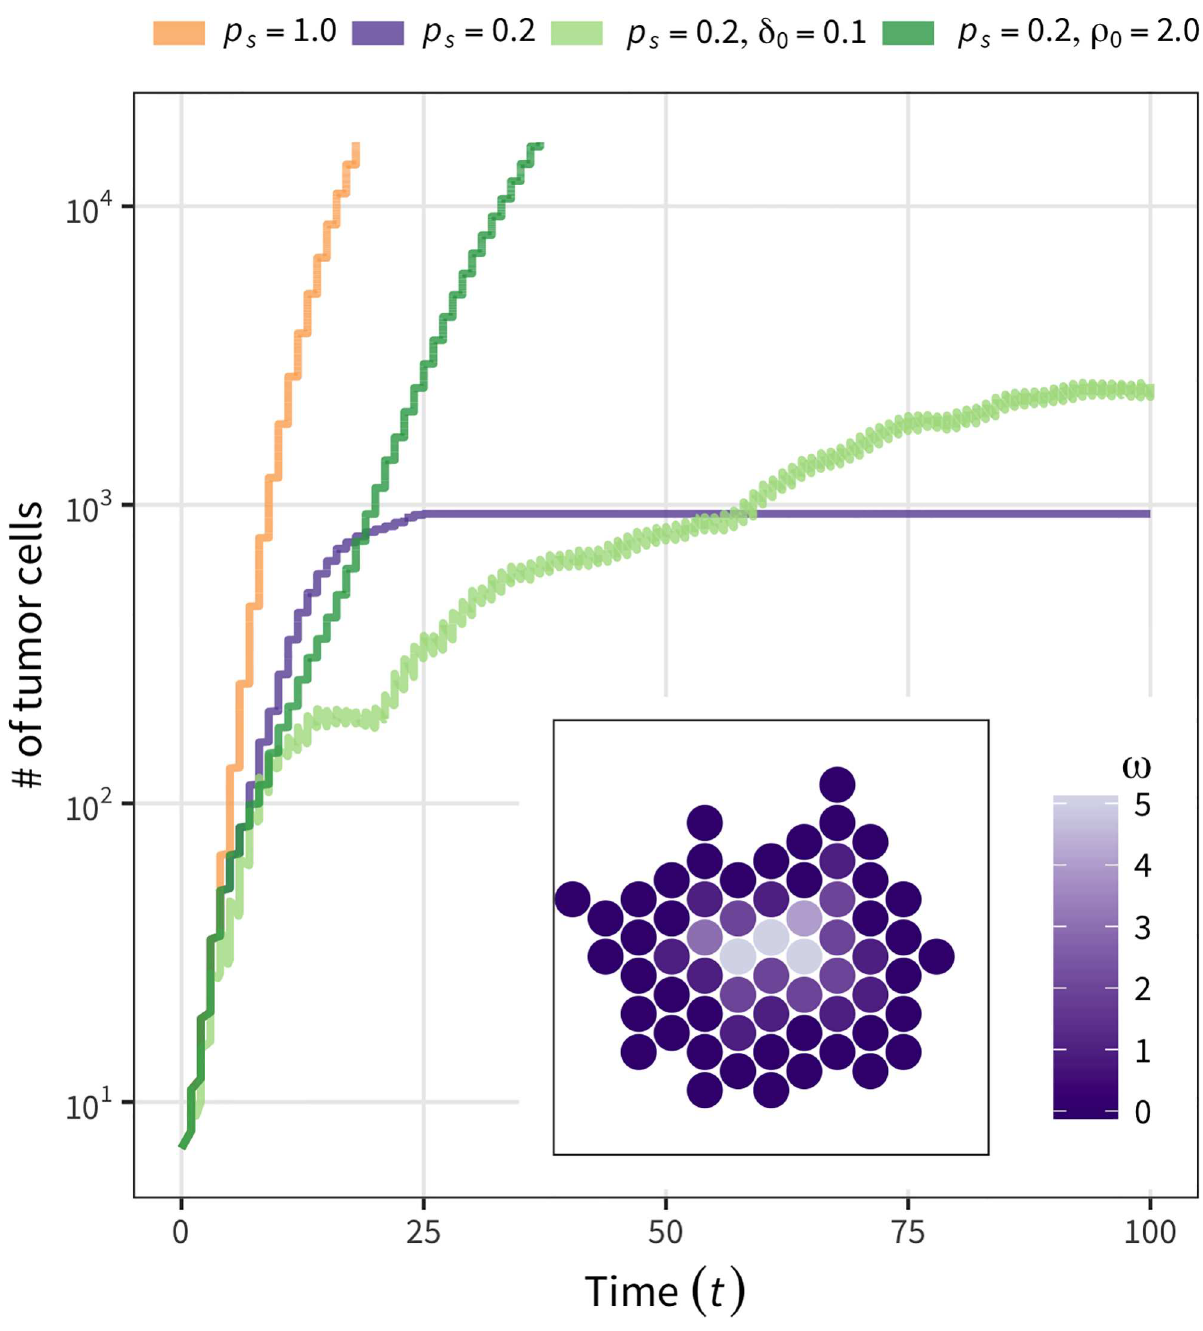
Fig 7. Typical tumor growth behavior when the assumption of all CSCs is relaxed. p s = 0.2 and ω max = 5 are assumed, except for the case of involvingall CSCs ( p s = 1) for comparison(yellowline). With no cell death or migration (purple line), growth likely stops when the tumor is surrounded by immortal TDCs (inner panel). This effect can be moderated by cell death and/or migration(light and dark green lines).